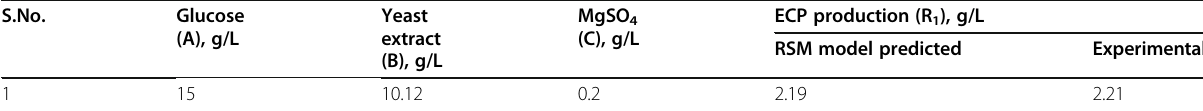
Table 7 Validation of RSM model for ECP production